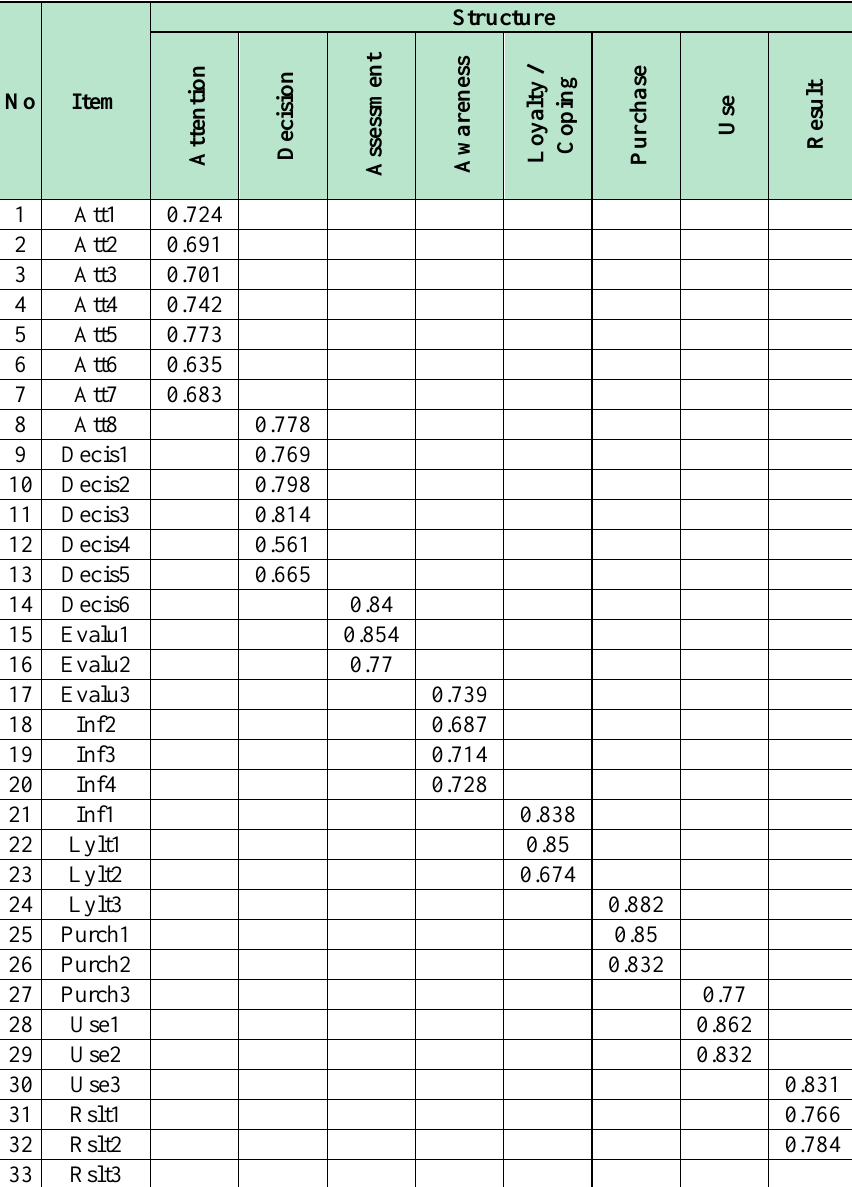
Table 3- Factor load of items in the final